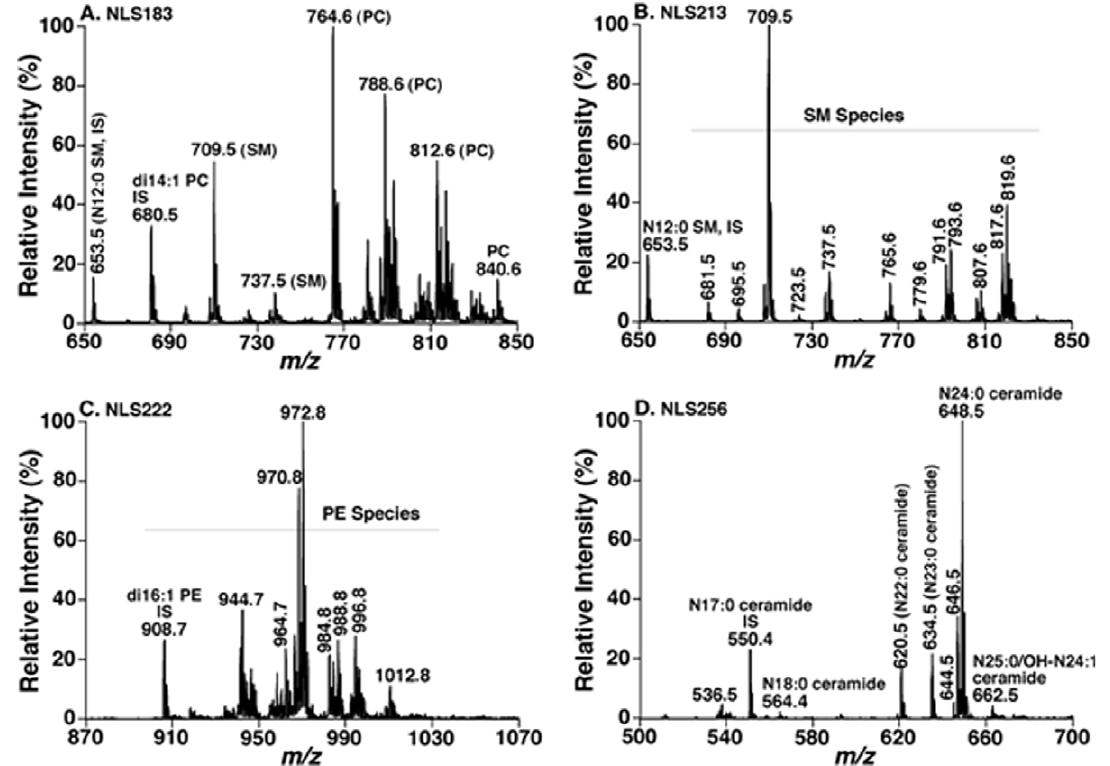
Figure 1. Representative tandem mass spectrometric analyses of lipid classes present in a human plasma lipid extract. Lipid samples were prepared and mass spectrometric analysis of individual sample was performed as described in ‘‘Material and Methods’’ in details. Panel A shows a mass spectrum of NLS183 (corresponding to the neutral loss of phosphocholine) displaying the presence of PC and SM species in the hexane- washed lipid solution; the spectrum was acquired in the positive-ion mode after addition of a small amount of LiOH to the lipid solution. Panel B shows a mass spectrum of NLS213 (corresponding to the neutral loss of phosphocholine plus methyl aldehyde) displaying the presence of SM species in the LiOMe-treated lipid solution; the spectrum was acquired in the positive-ion mode after addition of a small amount of LiOH to the lipid solution. Panel C shows a mass spectrum of NLS222 (corresponding to the neutral loss of Fmoc) displaying the presence of PE species in the hexane-washed lipid solution; the spectrum was acquired in the negative-ion mode after in situ addition of Fmoc-Cl to the lipid solution. Panel D shows a mass spectrum of NLS256 (corresponding to the neutral loss of 2-palmitoleyl aldehyde and a water molecule) displaying the presence of ceramide species in the LiOMe-treated lipid solution; the spectrum was acquired in the negative-ion mode after addition of a small amount of LiOH to the lipid solution. IS denotes internal standard; NLS stands for neutral loss scan.